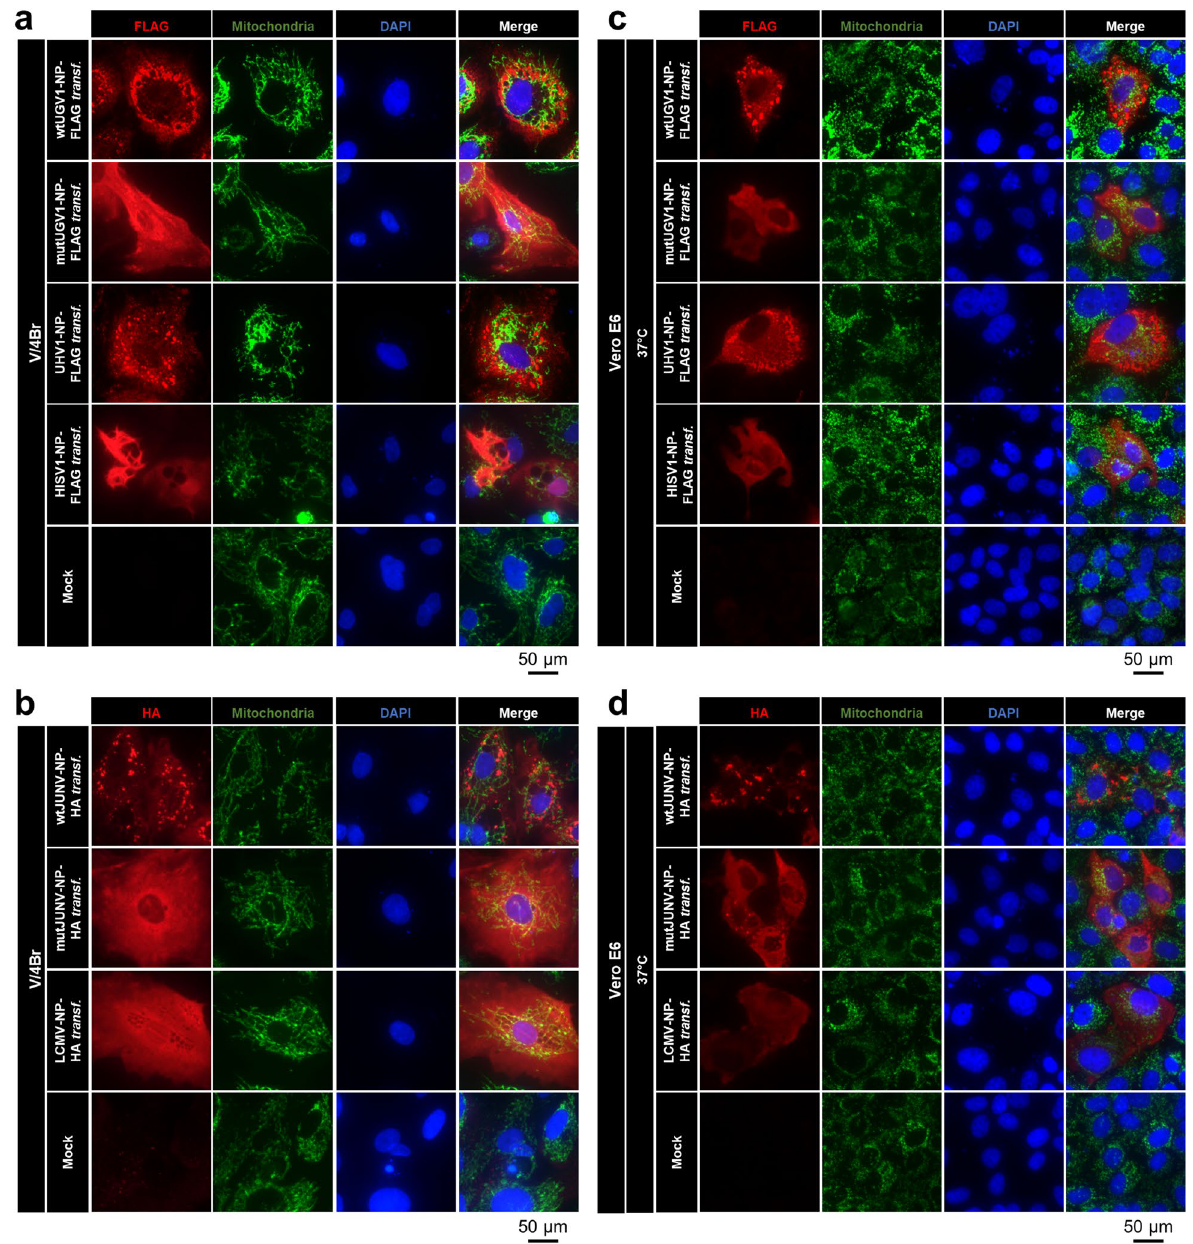
with a construct expressing either wt or mutUGV1-NP-FLAG, UHV1-NP-FLAG, or HISV1-NP-FLAG ( a , c ), and wt or mutJUNV-NP-HA, or LCMV-NP-HA ( b , d ) at three dpt. Non-transfected (Mock) cells served as controls. ( a , c ) The panels from left: FLAG tag in red (secondary antibody: AlexaFluor 594 goat anti-rabbit), mitochondrial marker in green (secondary antibody: AlexaFluor 488 goat anti-mouse), nuclei in blue (DAPI), and a merged image. ( b , d ) The panels from left: HA tag in red (secondary antibody: AlexaFluor 594 goat anti- rabbit), mitochondrial marker in green (secondary antibody: AlexaFluor 488 goat anti-mouse), nuclei in blue (DAPI), and a merged